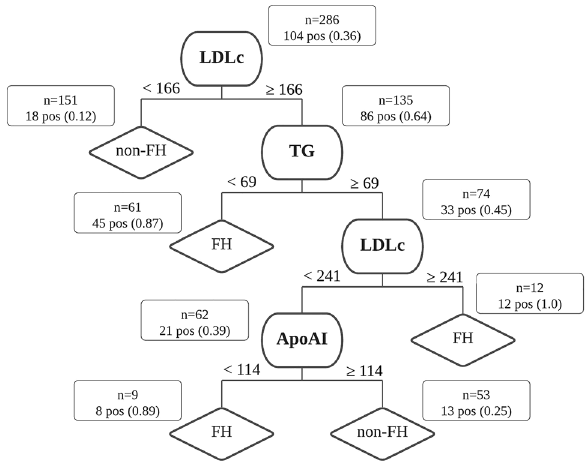
Figure 2. Decision tree model. At each node, it is represented the biochemical indicator used to divide the sample, the respective cut-off value, and the way the original sample is divided throughout the tree. FH familial hypercholesterolemia, LDLc low density lipoprotein cholesterol, in mg/dL, TG triglycerides, in mg/dL, ApoAI apolipoprotein AI, in mg/dL, pos positive